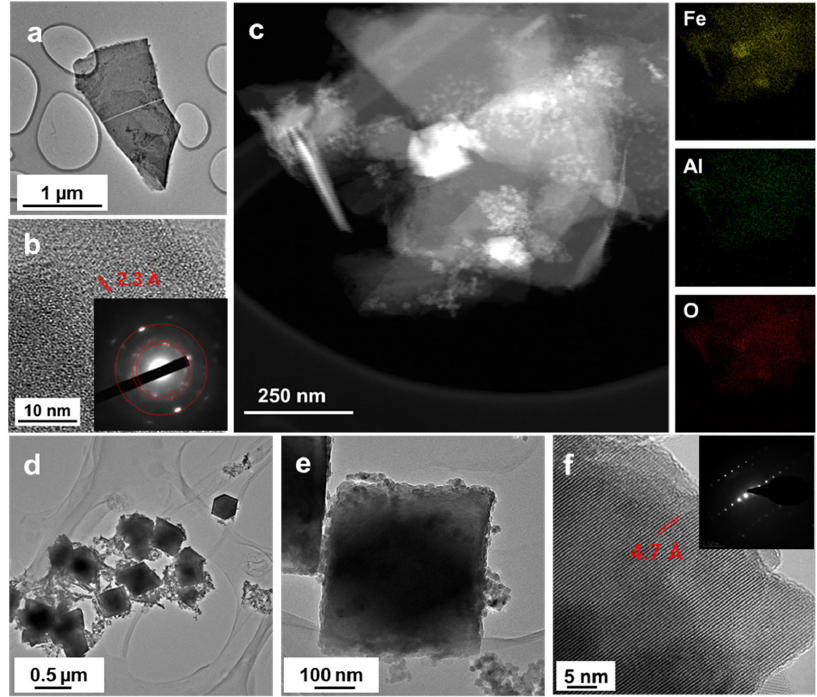
Figure 4. ( a ) TEM, ( b ) HRTEM, ( c ) STEM, and corresponding elemental mapping images of FeAl- LDH nanosheets. Inset ( b ) corresponding SAED pattern. ( d , e ) TEM and ( f ) HRTEM images of Fe 3 O 4 nanooctahedrons. Inset ( f ) corresponding SAED pattern.